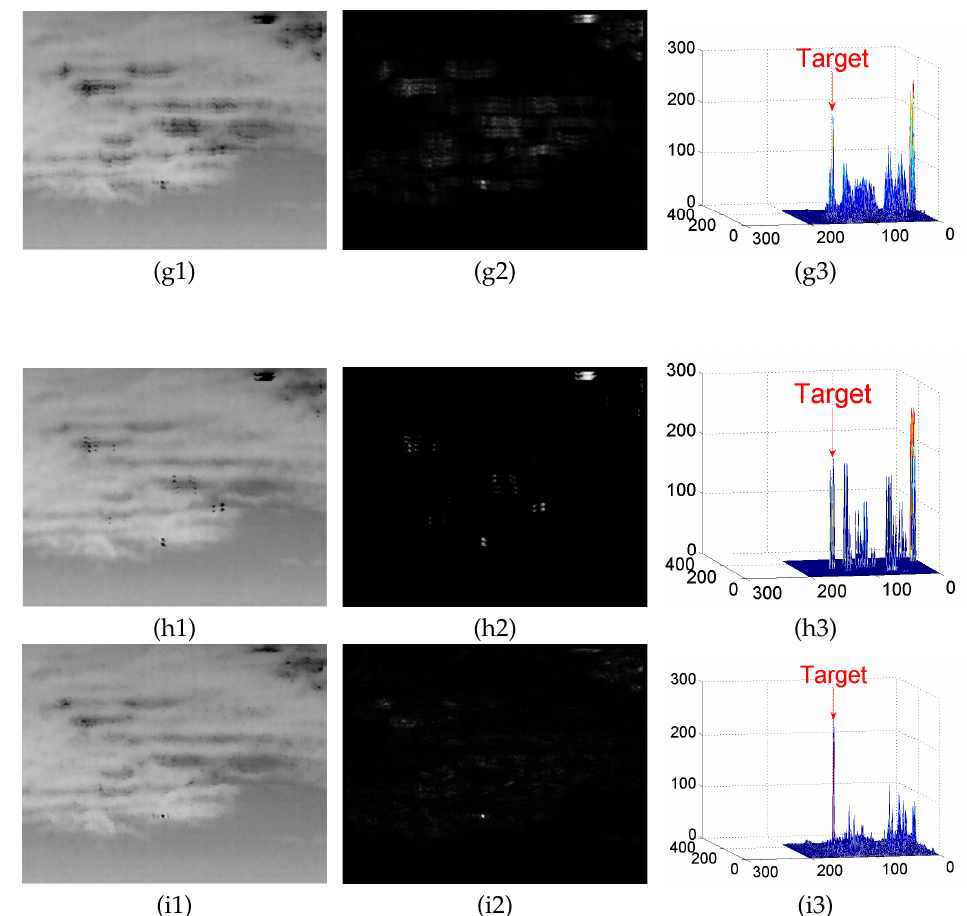
Figure A7. ( a – i ) denote the detection results of the PSTNN, RPCA, TV-PCP, VNTFR, ASTTV, SRWS, C2, C3, and proposed algorithm on sequence H, respectively, where ( a1 – a3 ) denote the background map, the differential map, and the 3D map of the obtained differential map, respectively.